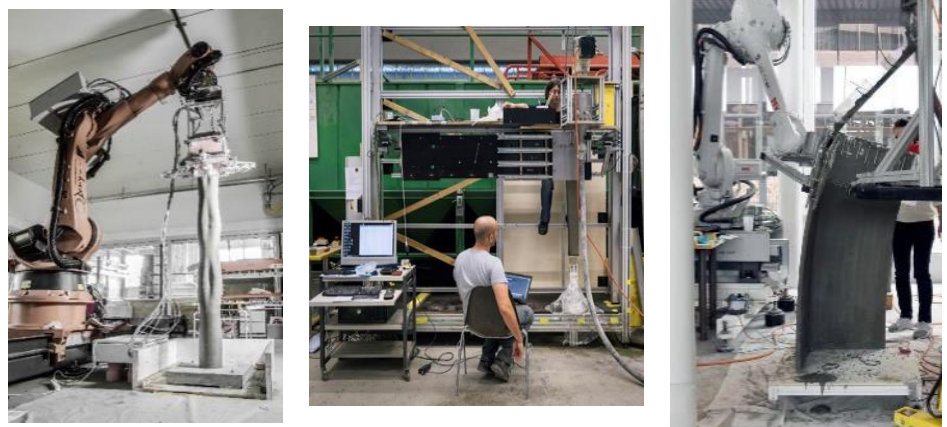
Figure 1. The different fabrication setups of smart dynamic casting (SDC) for producing columns on the left with a KUKA robotic arm [9], mullions in the middle with a linear axis [16], and thin folded structures on the right with an ABB robotic arm [12].